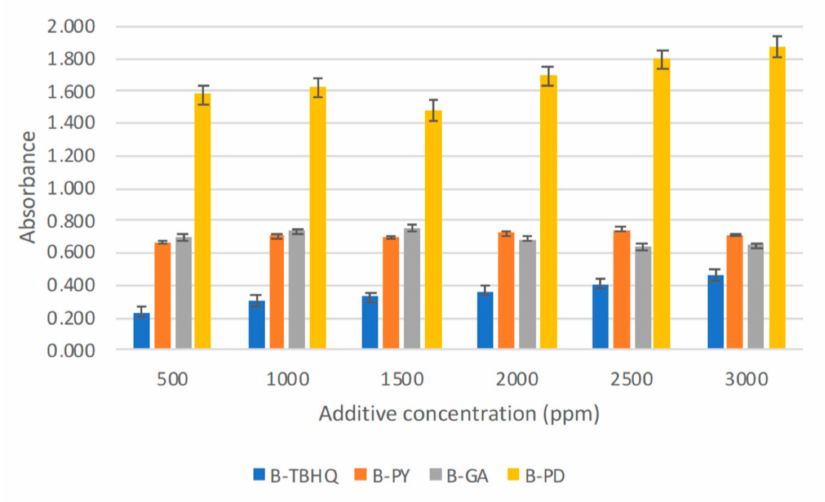
Figure 13. Solubility of di ff erent additives in